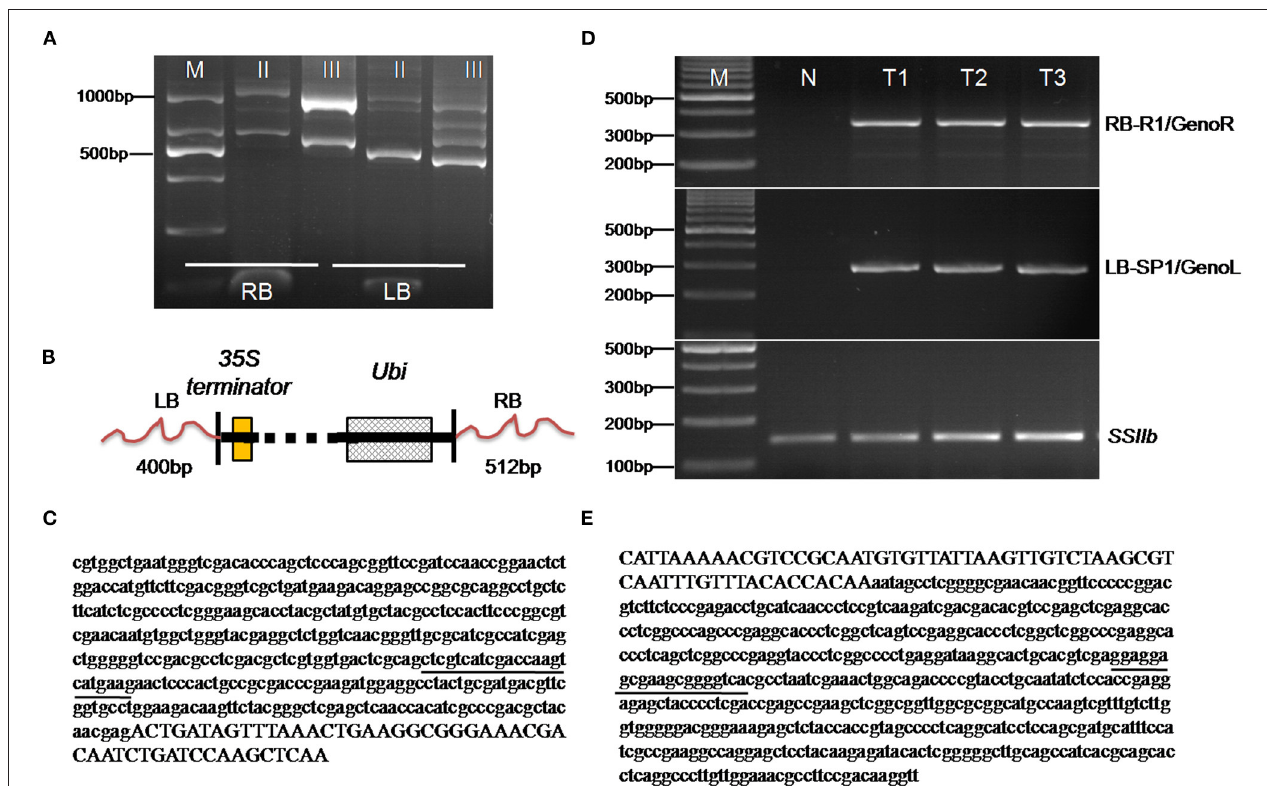
FIGURE 3 | Isolation and identification of the flanking sequences of SK 12-5. (A) The analysis of thermal asymmetric interlaced polymerase chain reaction (TAIL-PCR) products from the SK12-5 insertion line. M denotes the 1,000-bp DNA ladder, while lanes II and III indicate the products of the secondary and tertiary reactions, respectively; RB and LB indicate the products of right border and left border, respectively. (B) Schematic diagrams of the integrated heterologous DNAs in SK12-5. (C,E) Sanger sequencing of the amplified thermal asymmetric interlaced polymerase chain reaction (TAIL-PCR) products in the LB and the RB of SK12-5, respectively. The sequence of the maize genome at both LB and RB is denoted by lowercase letters and that of T-DNA by capital letters; underlined are the primers of GenoL and GenoR on the maize genome. (D) Validation of the LB and RB flanking sequences from SK12-5. M, the 1,000-bp DNA ladder; N, non-transgenic maize line Zheng58 as the negative control; and T1–T3, the three samples of SK12-5.